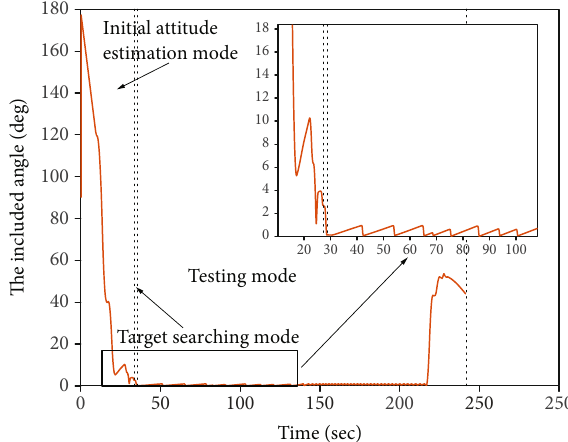
Figure 8: Time history of the included angle between the satelliteâ € ™ s x axis and the array pointing from the satellite to the target during all modes.